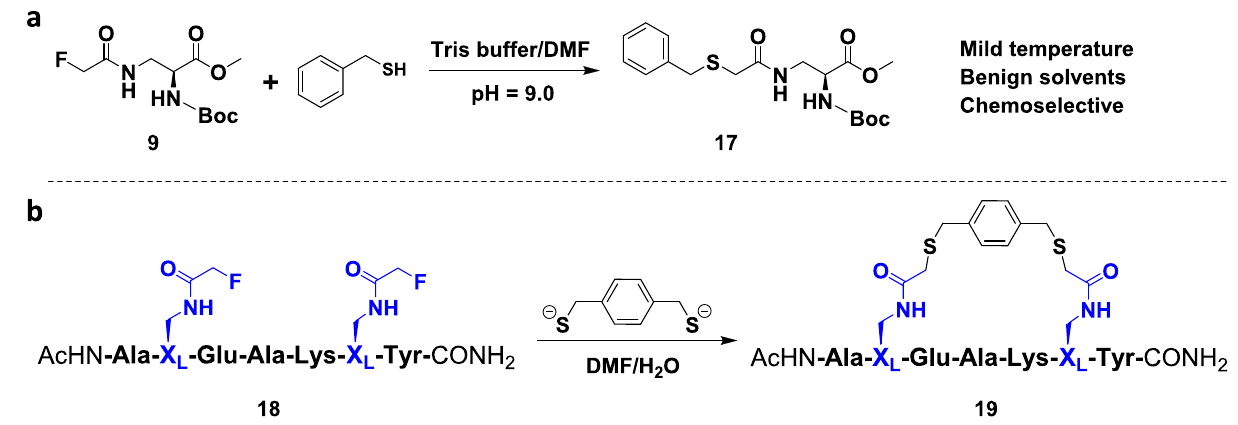
Fig. 1 Fluorine thiol displacement reactions (FTDRs). a A model reaction between benzyl thiol and the α - fl uoroacetamide containing amino acid building block 9 . b A model macrocyclization carried out between unprotected model peptide 18 and a commercially available linker 1,4-benzenedimethanethiol based on FTDR (pH = 9.0 – 9.5). The α - fl uoroacetamide containing amino acid X L is highlighted in blue.